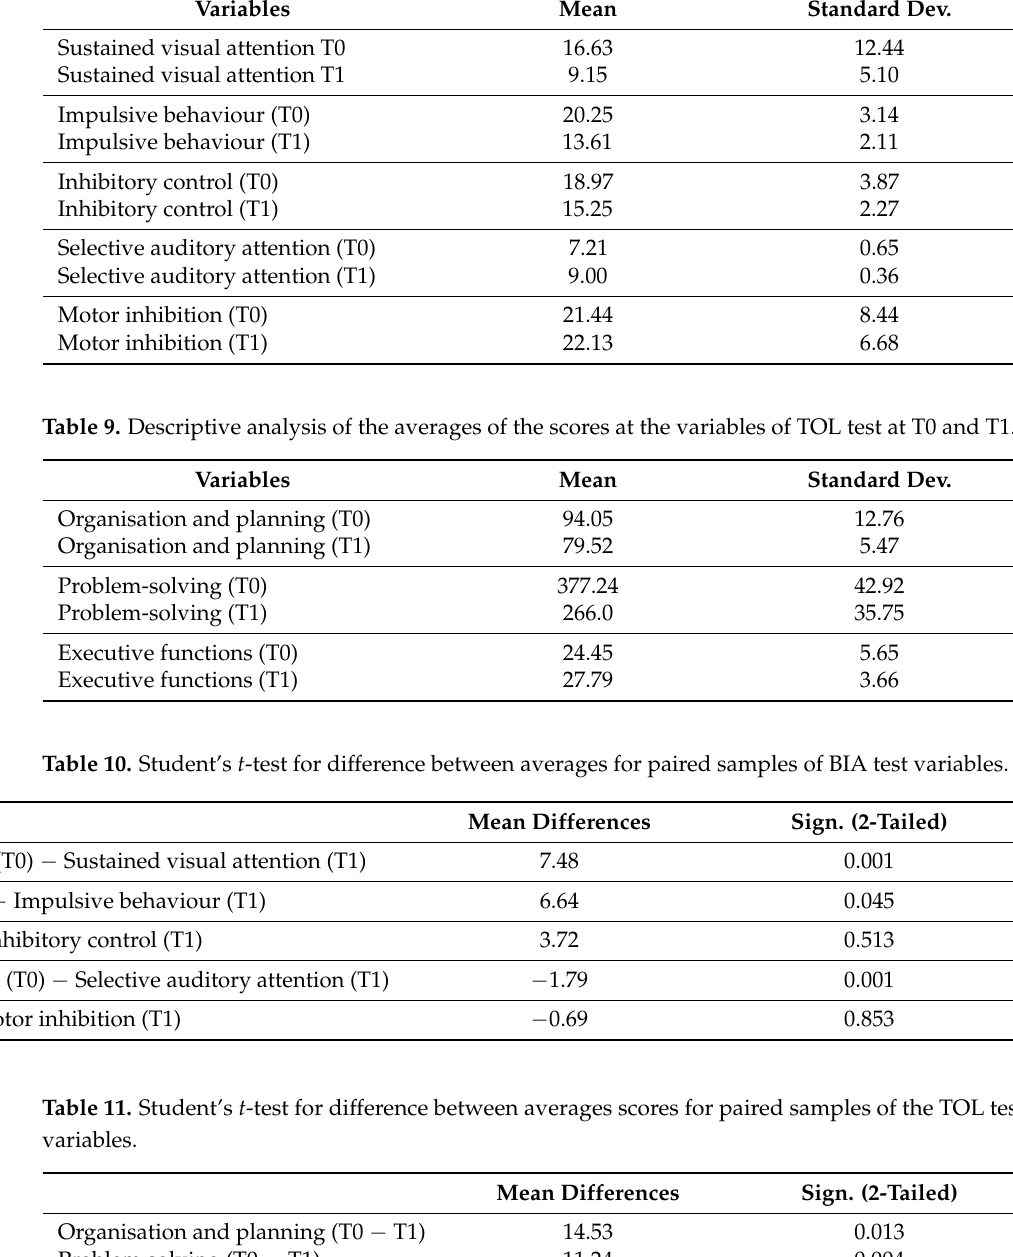
Table 8. Descriptive analysis of the averages of the scores at the variables of the BIA test at T0 and T1. Variables Mean Standard Dev.